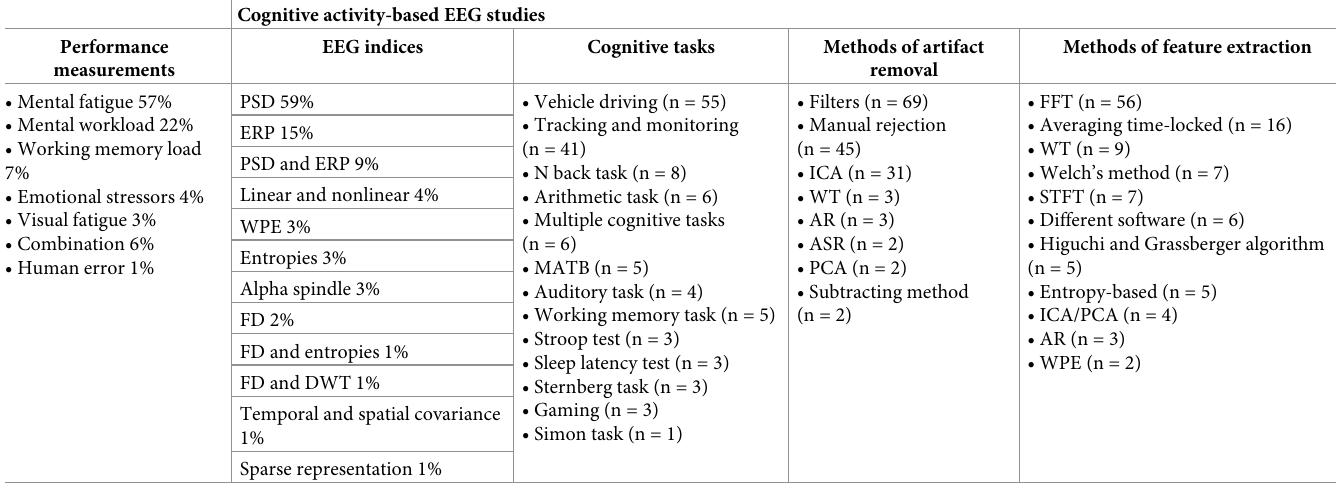
Table 1. A comprehensive summary of the findings from the